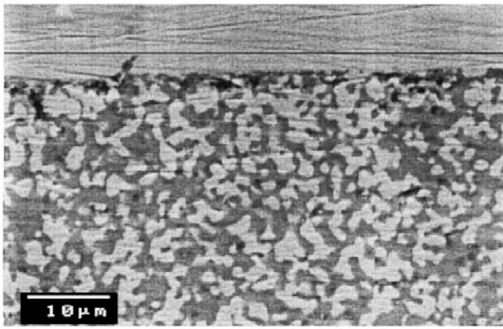
Figure 10. Cross section SEM image of Pd-YSZ membrane after exposure to H 2 S at 600 °C. Reprinted from [186] with permission from Elsevier.